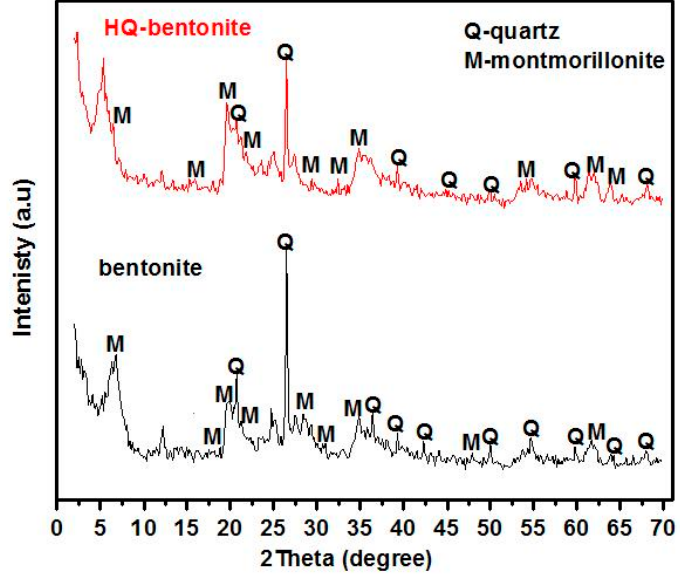
Figure 1. X-ray di ff raction (XRD) analysis of Na-bentonite and Figure 1. X-ray diffraction (XRD) analysis of Na-bentonite and HQ-bentonite.